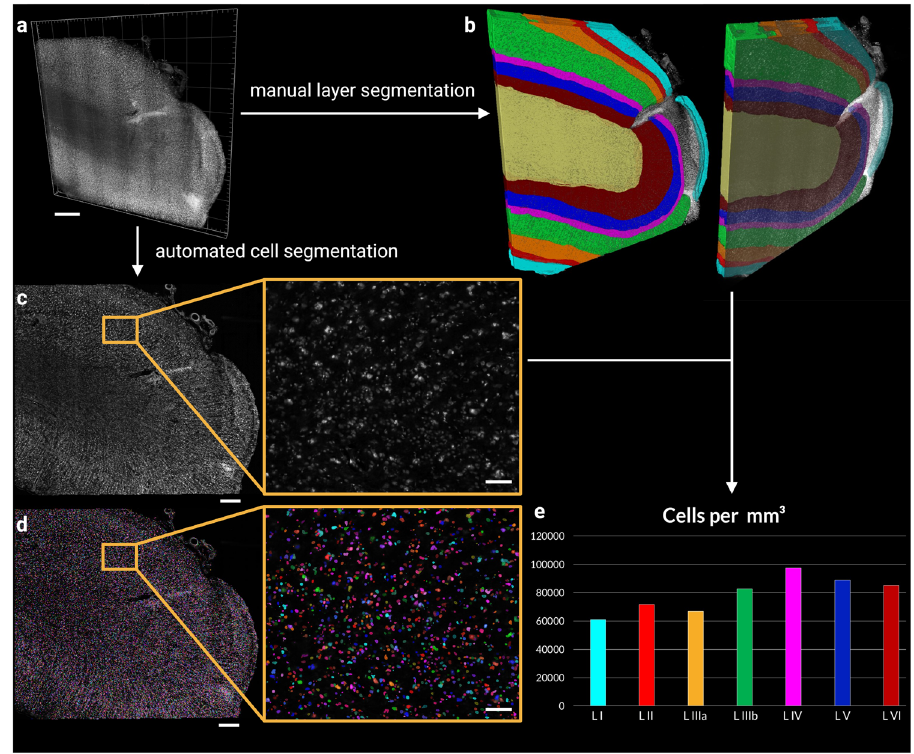
Fig. 5 Segmentation and cell counting in a high resolution (0.725 µ m × 0.5127 µ m × 0.5127 µ m), single-view volume of human brain tissue. a Volume rendering of the data set used for the cell counting. b Results of the manual layer segmentation for the entire volume. Colours are as follows: Layer I cyan, Layer II bright red, Layer IIIa orange, Layer IIIb green, Layer IV magenta, Layer V blue, Layer VI dark red, and white matter in yellow. The tissue in the unsegmented part of the volume was damaged and did not allow for the segmentation of layers and was excluded from the analysis. Single plane ( XY plane of the resliced image volume) of the fi ltered data ( c ) and automatically segmented objects ( d ). Segmented cells are shown in random colours. e Cell density estimates derived from the total count of all the segmented cells per layer segment over the entire image volume (for multiple, unconnected segments of the same layers, the counts were pooled). Colours as indicated for ( b ). The scale bars for all the images in the left-most side are 500 µ m and for the two zoomed-in panels 75 µ m.